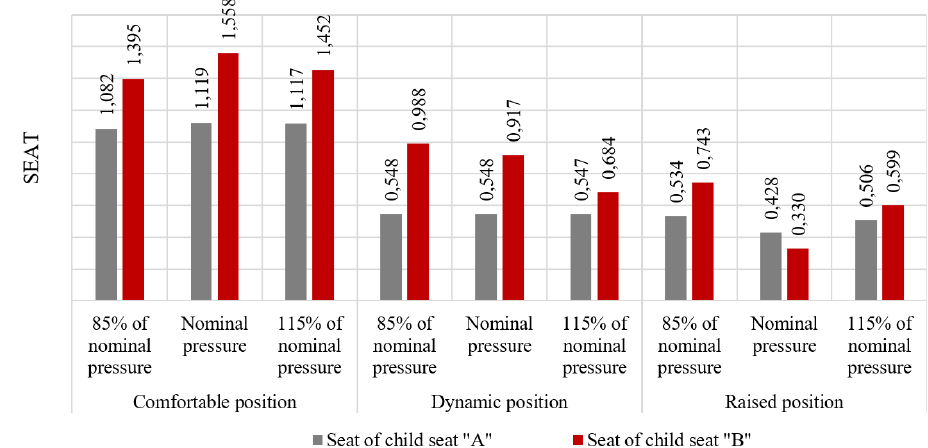
Figure 19: SEAT indicator on the seat of the tested child seats with a mass of 12.5